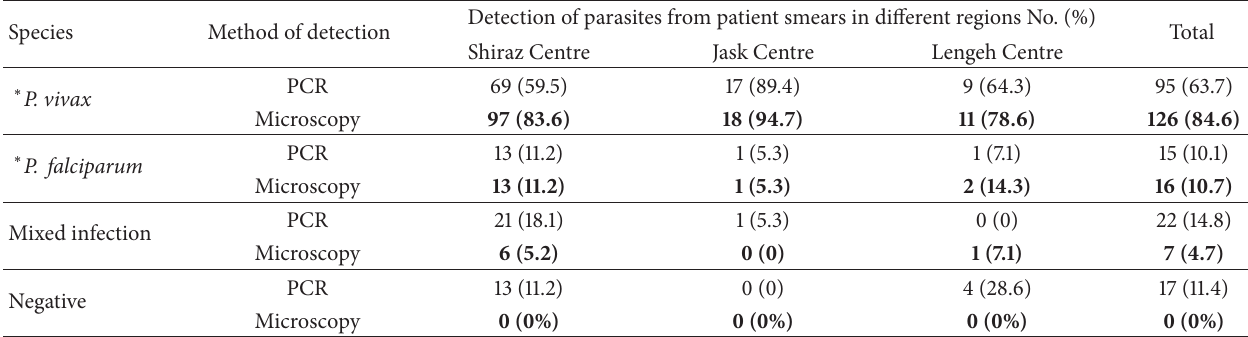
Table 1: Frequency of malaria cases ( P. vivax , P. falciparum , mixed infection and negative cases) based on microscopy and PCR in different studied areas.